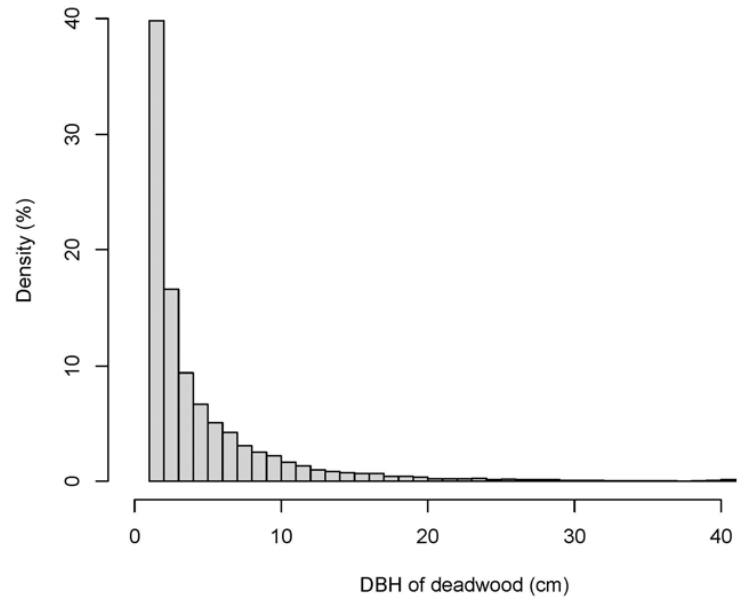
Figure 3. Distribution of breast diameter of dead trees in the 20 ha study plot.